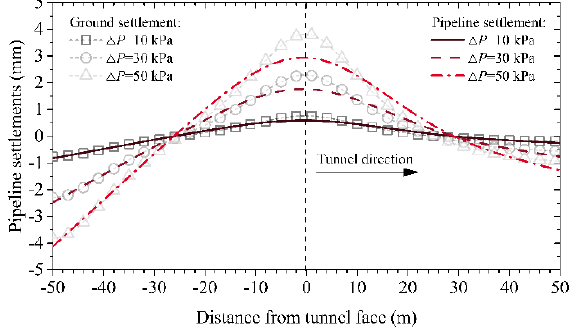
Figure 13. Longitudinal profiles of pipeline’s deformation with different support pressures.